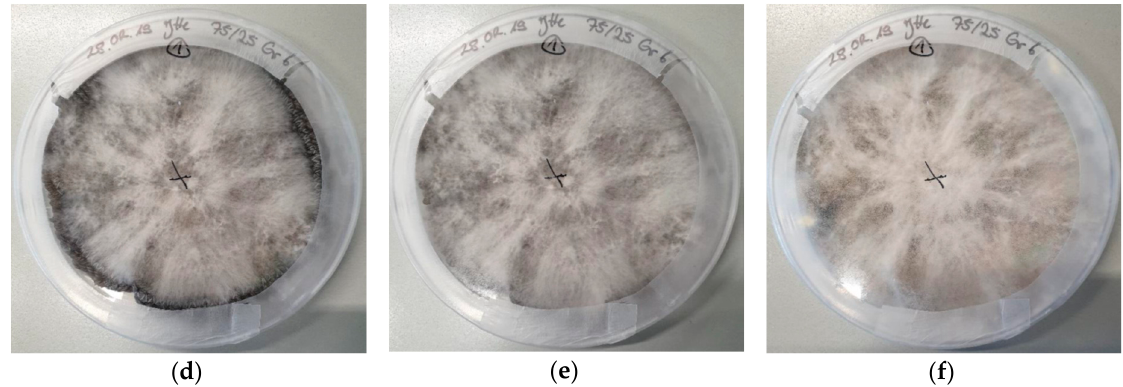
Figure 4. Pleurotus ostreatus mycelium grown on a cotton/linen fabric with stitch size 6 after different growth times: ( a ) 0 days; ( b ) 4 days; ( c ) 6 days; ( d ) 7 days; ( e ) 8 days; ( f ) 15 days.